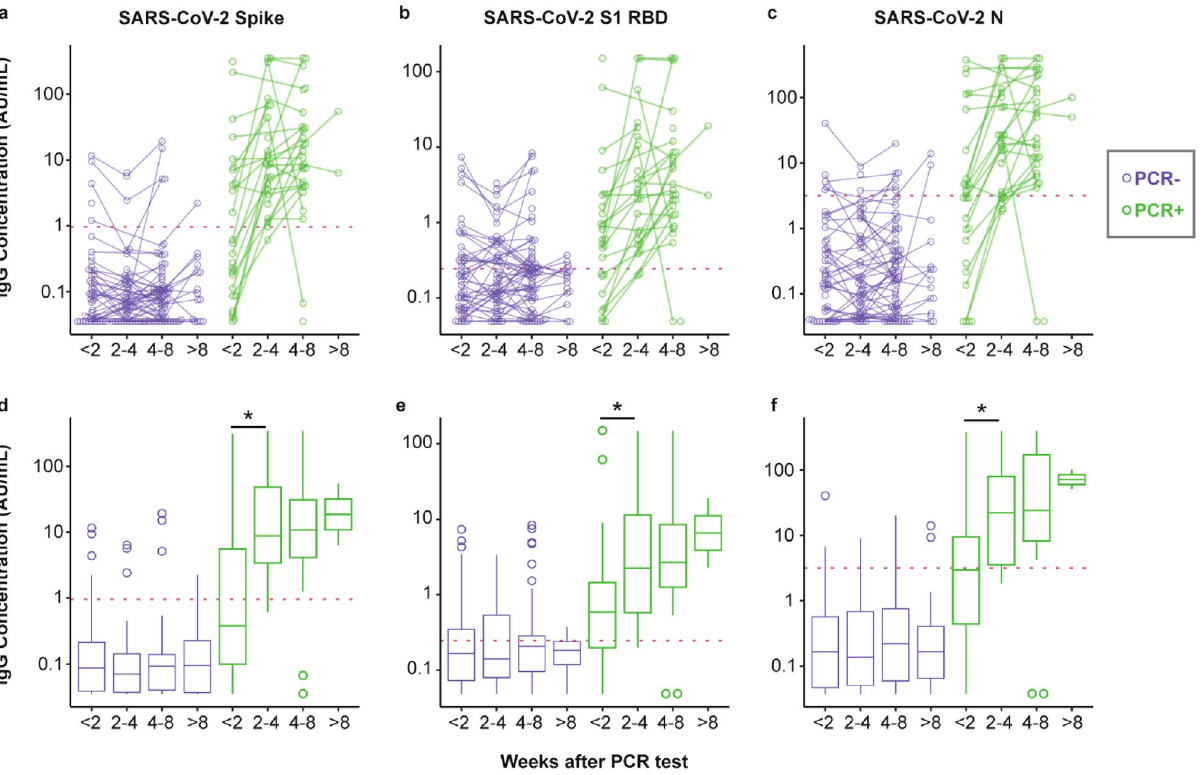
Figure 1. Salivary anti-SARS-CoV-2 IgG antibodies in the weeks after a PCR test. Reactivity to ( a ) full-length spike protein, ( b ) receptor binding domain (RBD) of the spike protein, and ( c ) N protein of SARS-CoV-2 were measured in saliva provided by 121 participants who had received a PCR test for SARS-CoV-2. Participants provided up to three samples. Matched samples provided by the same donor are connected with lines. 81 participants tested negative for SARS-CoV-2 (colored purple), and 40 participants tested positive (colored green). The dashed, red line indicates the pre-established cut-point for high versus low antibody levels. ( d – f ) Box and whisker plots of the same data shown in panels ( a – c ). The PCR + cohort was significantly different (p < 0.001; see Supplemental Tables) from the PCR- cohort at all timepoints. Asterisks indicate statistical significance (p < 0.05 by Mann–Whitney test) for difference between the < 2 weeks and 2–4 weeks timepoints.